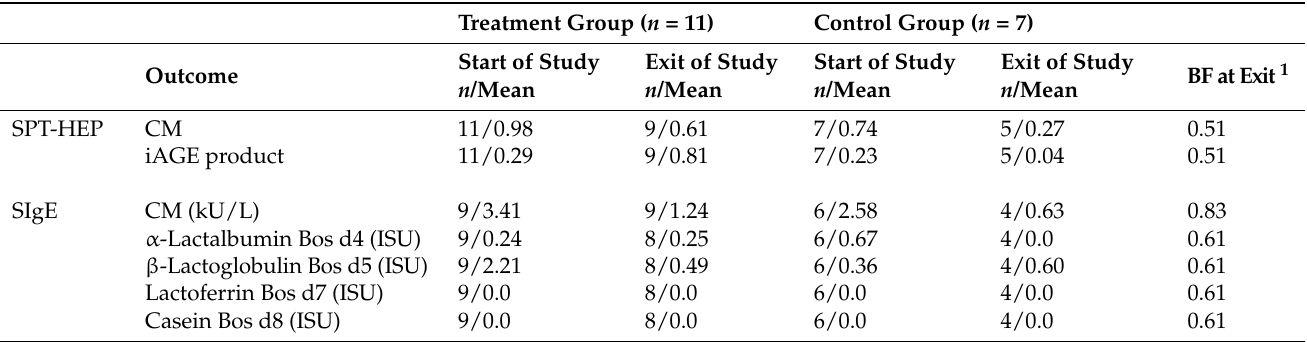
Table 4. Sensitization to cow’s milk in SPT and sIgE at the onset of the intervention and at the end of intervention (negative DBPCFC = exit of